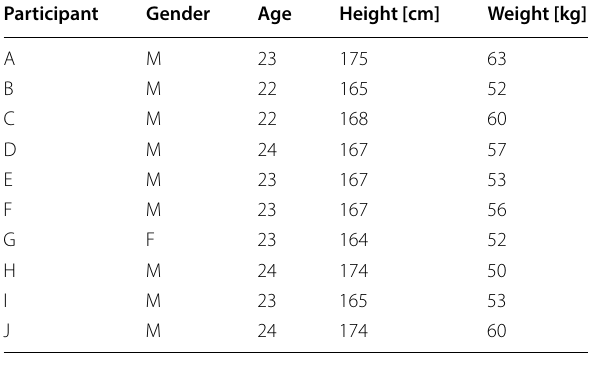
Table 2 Basic information of the participants